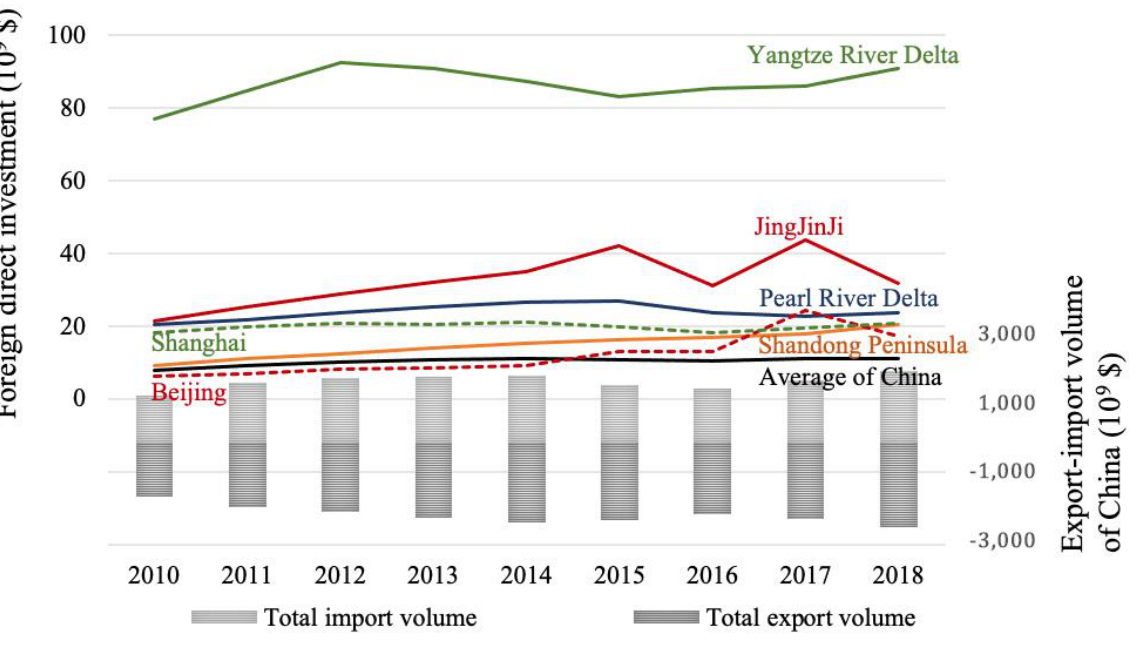
Figure 5. The trend of urban attraction in China from 2010 to 2018. (Data source: China Statistical Yearbook 2011 – 2019 [36]).